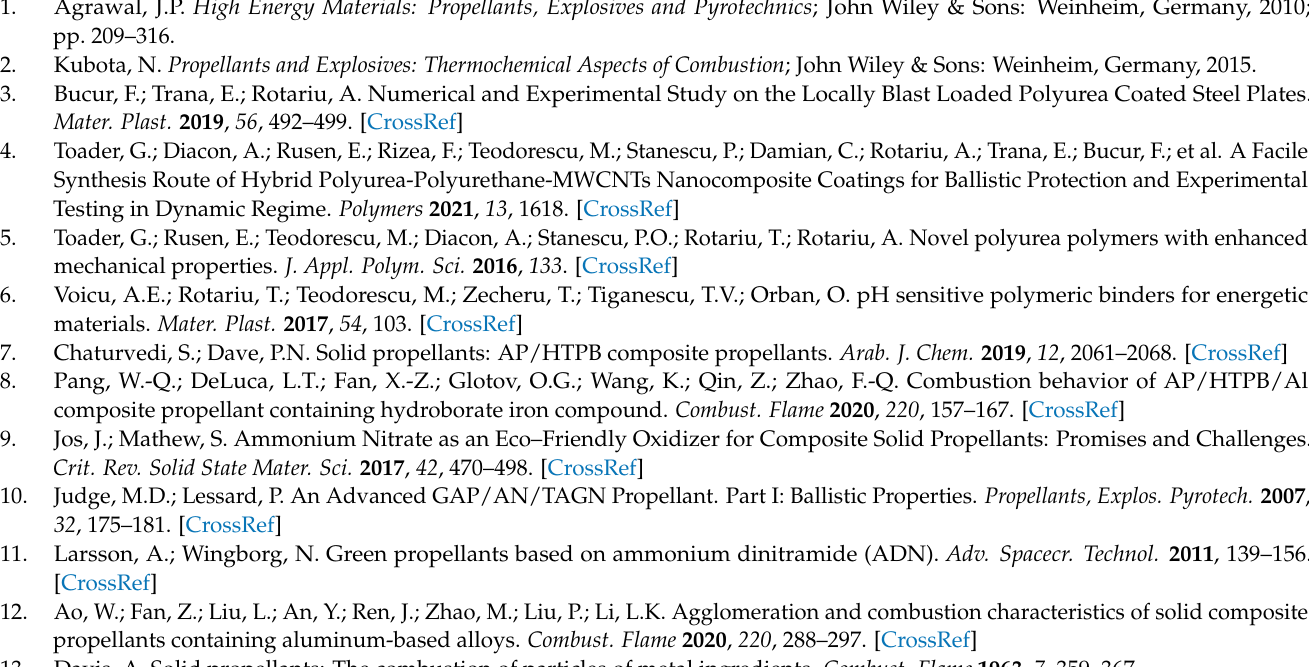
(Figure S19), behavior of PUs during manual bending (Figure S20), structural configurations of composite propellants for mechanical analysis (Figure S21), weight and atomic composition of free oxidizer composite formulations (Table S1), weight and atomic composition of free binder solid mixture (Table S2), thermal characteristics for polyurethane films, composite propellant formulations, and energetic plasticizer (Table S3), thermal properties of synthesized polyurethanes (Table S4), the decomposition process of the polyurethanes (weight loss versus temperature) (Table S5), and heat of combustion, specific volume and Tg for our new composite propellants in comparison with the existing commercial formulations (Table